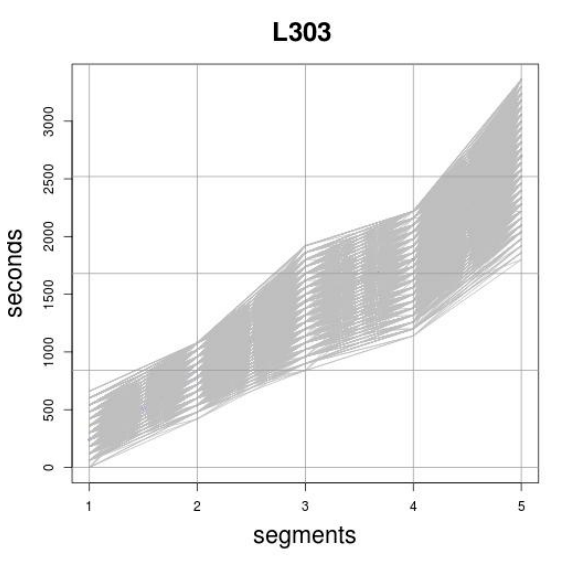
Figure 1. Illustration of travel time ( TT ) records clustering with five